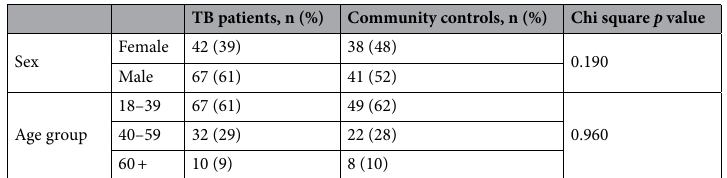
Table 1. Characteristics of pulmonary TB patients (N = 109) and TST-negative community control group participants (N = 79).